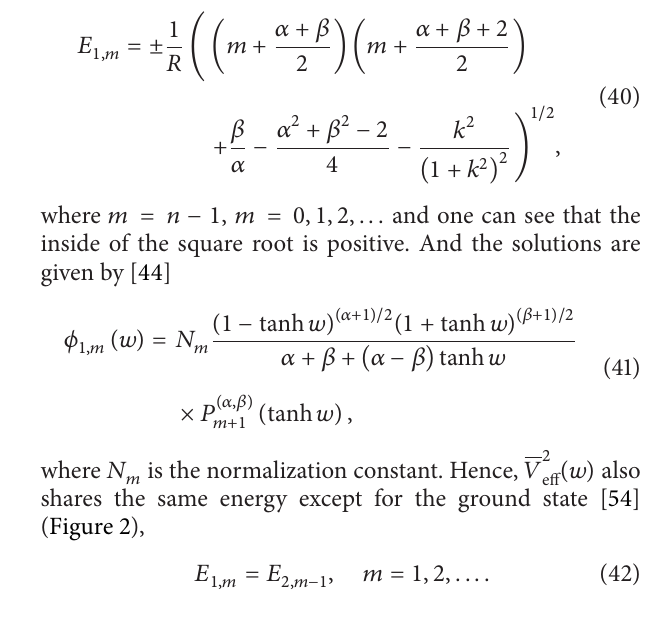
Under these constraints, 𝑉